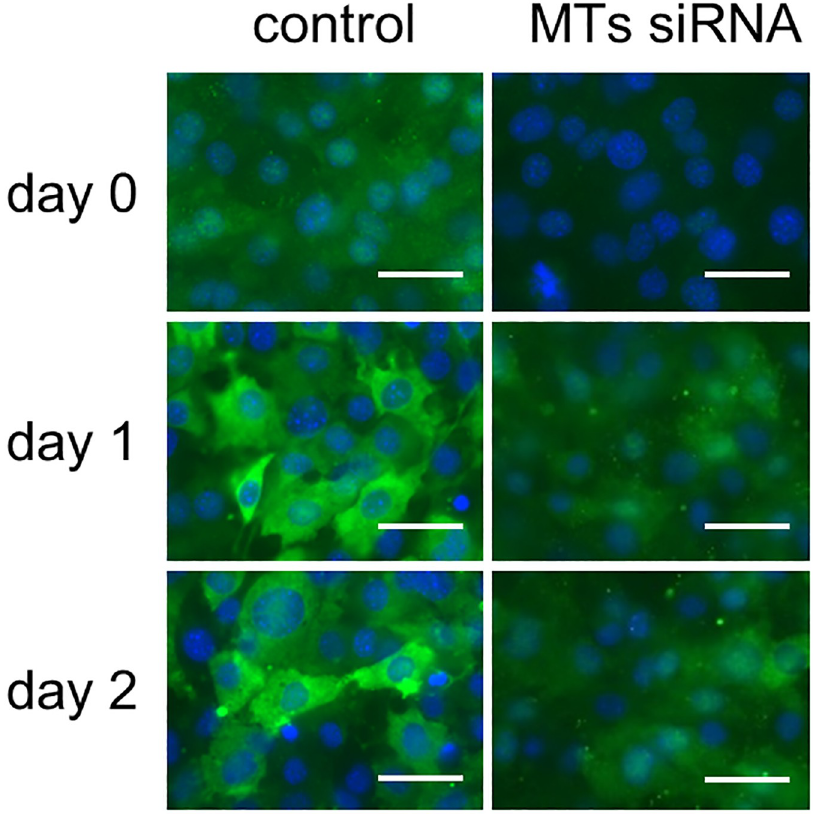
Fig 3. Effects of MTs siRNA on the expression of MT1 and MT2 total proteins. 3T3-L1 preadipocytes were treated with 50 nM control RNA or MTs siRNA 24 h before the additionof DIM (day -1). The cells were fixed with 4% paraformaldehyde on day 0, 1, and 2, and the expressionof MT proteins was detected using a primary antibody againstmouse MT1 and MT2 total proteins followedby Alexa Fluor 488-conjugated secondary antibody (Green). Nuclei were stained with Hoechst 33258 (blue). Bar = 40 μ m.